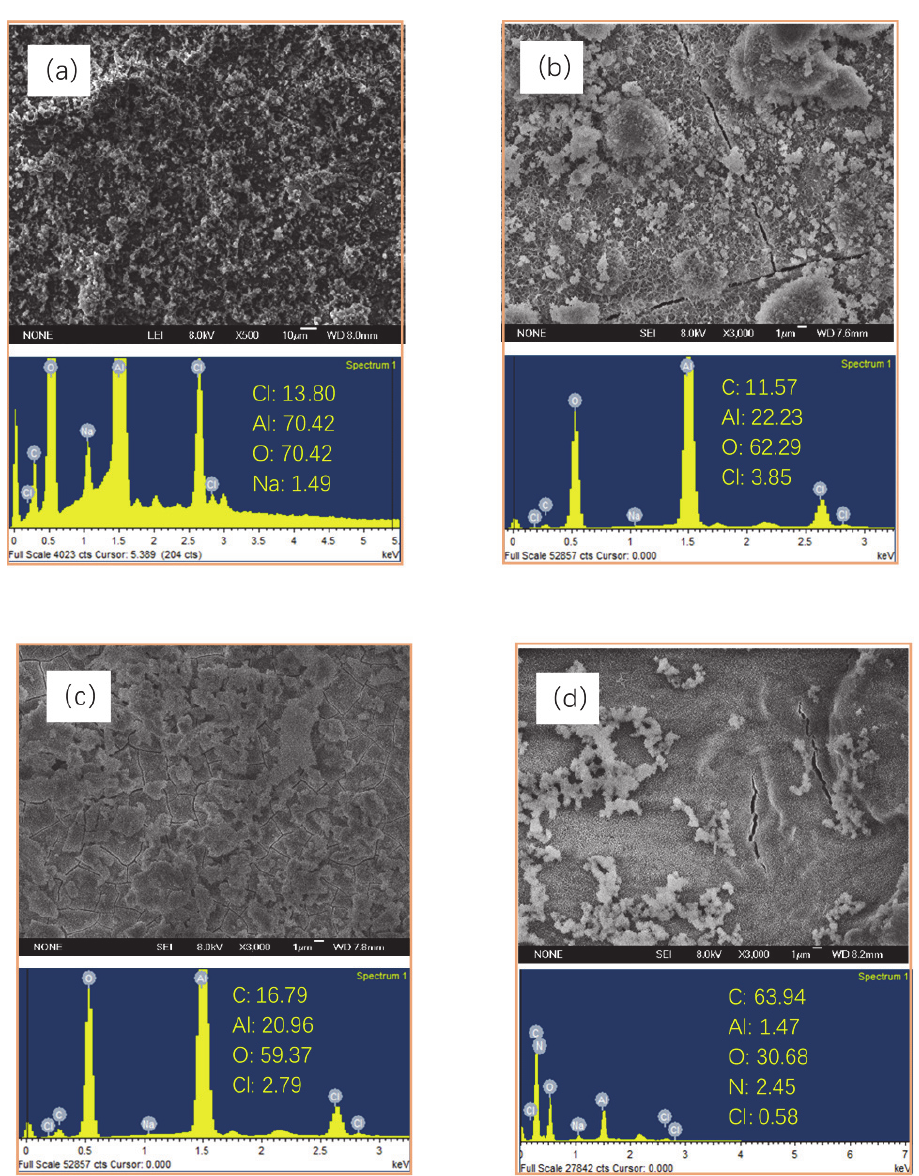
Figure 9. The surface morphology of ( a ) the blank Al alloy, ( b ) anodic oxide film, ( c ) sol–gel film, ( d ) LBL film, and EDS images after the salt spray test for 168 h.